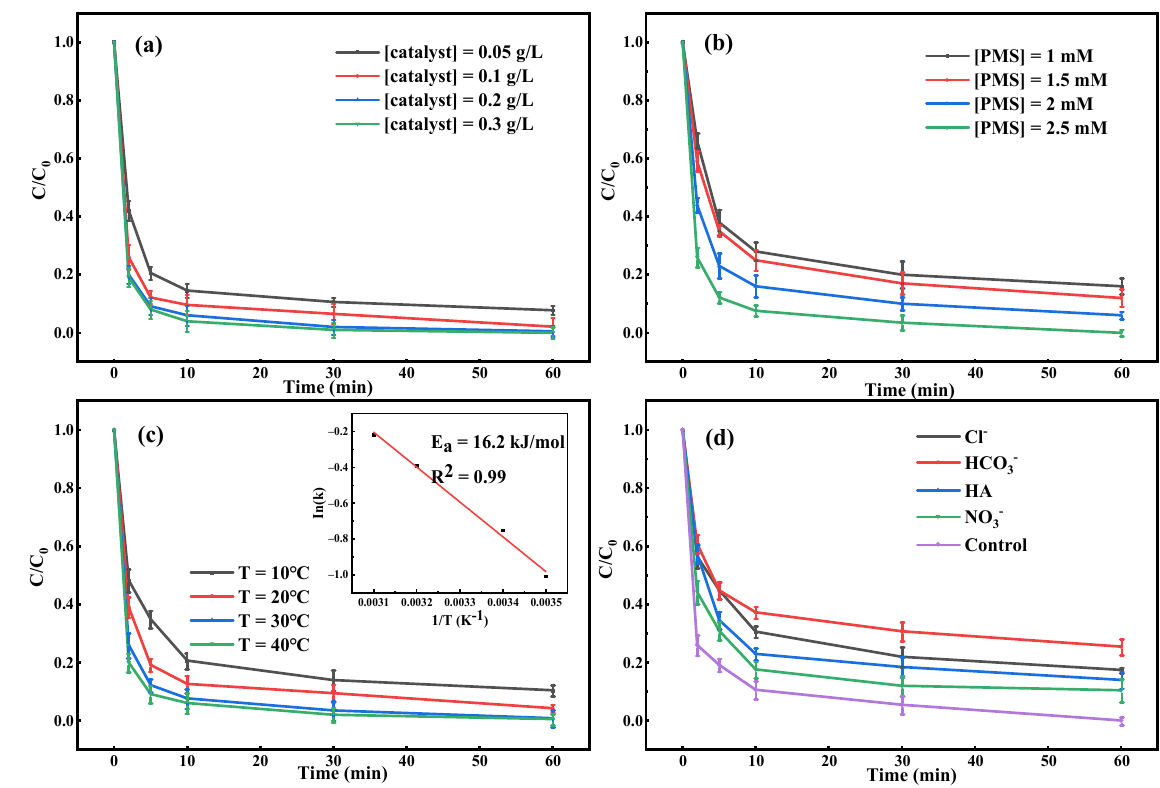
Figure 5. Influences of the ( a ) activator loading, ( b ) PMS dosage, ( c ) reaction temperature, and ( d ) various anions (10 mM) and HA (10 mg/L) on the CIP removal efficiency. Reaction conditions: [CIP] = 10 mg/L, [catalysts] = 0.1 g/L, [PMS] = 2.5 mM, initial pH = 7.0, T = 25 °C.